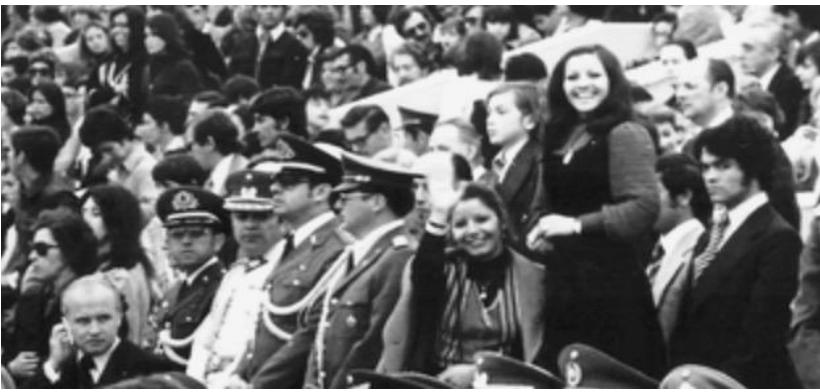
Figure 6. Adriana Rivas, pictured waving, in the early 1970s; frame from El pacto de Adriana (Orozco 2017). Picture courtesy of Lissette Orozco.